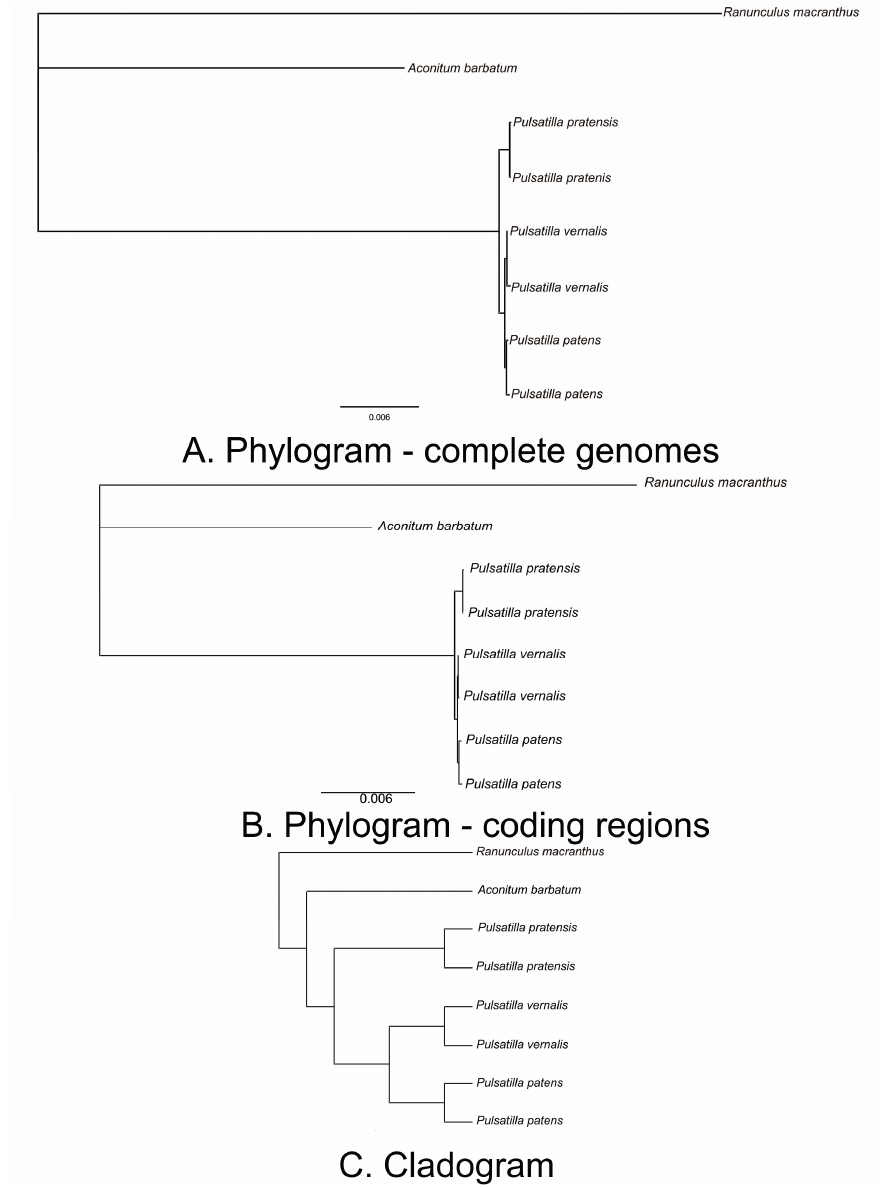
Figure 4. Phylogenetics relationships among studied species based on Bayesian analysis using the general time reversible + gamma (GTR + G) model. All clades are supported by Bayesian interference with posterior probabilities >0.95. ( A ) Phylogram based on complete plastomes; and ( B ) phylogram based on coding regions (CDS), tRNA and rRNA; ( C ) Cladogram given for the better visualization of the relationships among